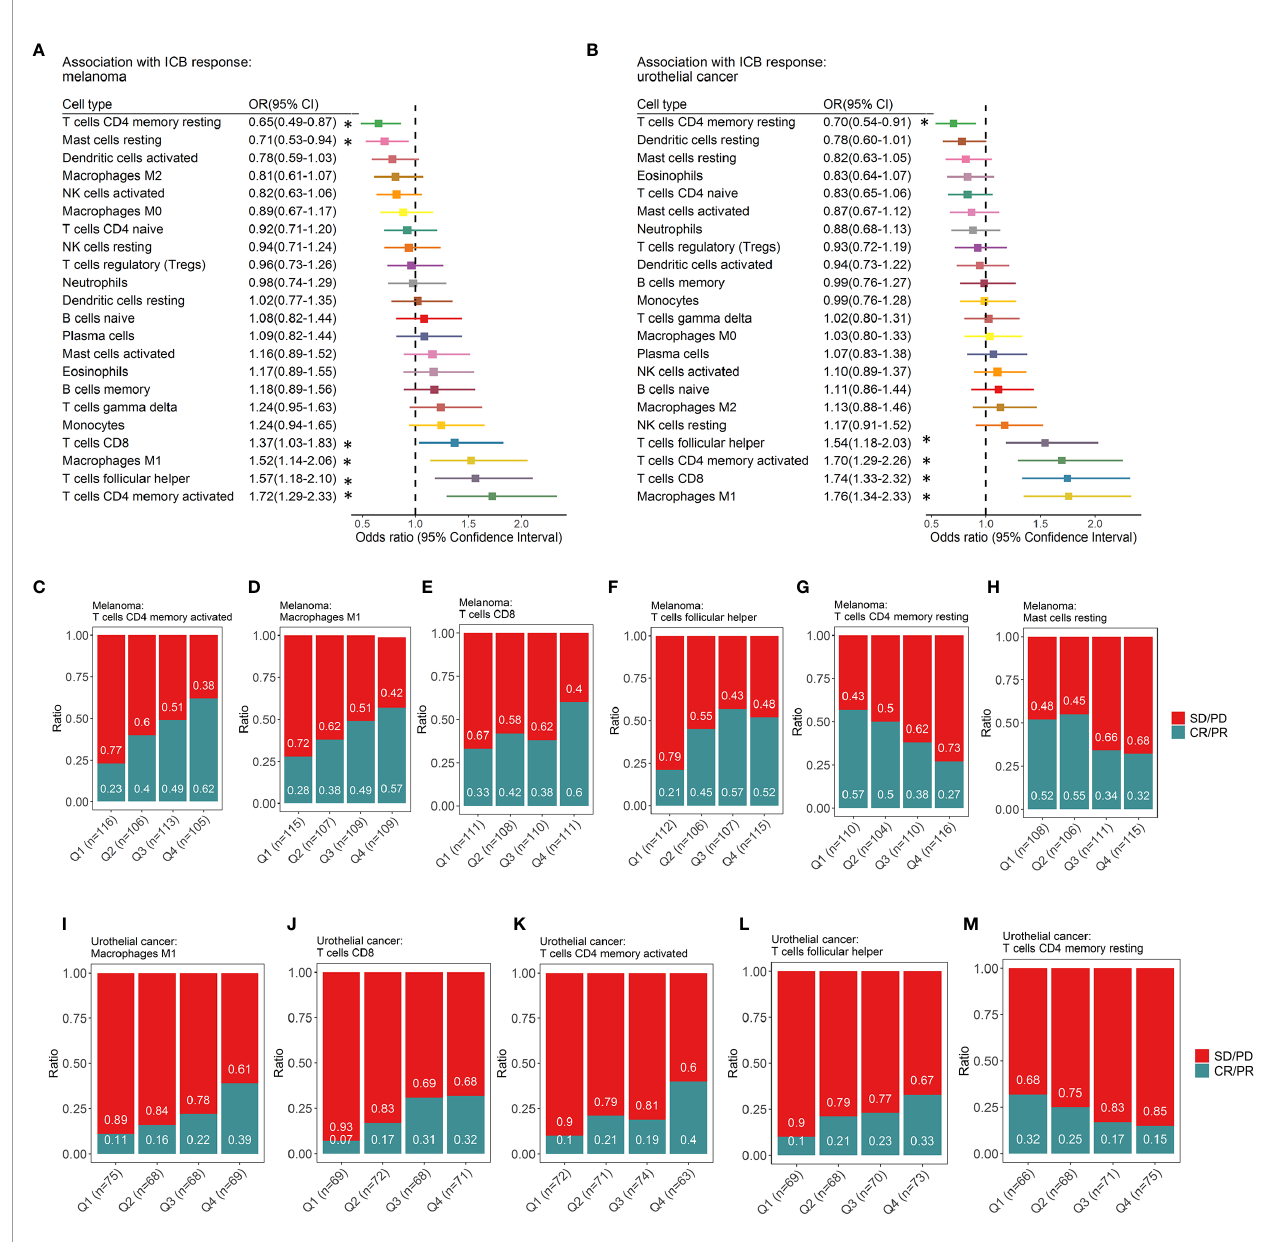
FIGURE 4 | Associations between ICI response and tumor-in fi ltrating immune cell subtypes. Forest plot demonstrating ORs (boxes) and 95% CIs (horizontal lines) for the association with response to ICI therapy in melanoma (A) and urothelial cancer (B) . The size of the box is negatively proportional to the standard error of the OR. * denote ORs with a p-value < 0.05. Spine plots demonstrating the distribution of response rates within quartiles of immune cell subsets (C-M) . OR, odds ratio; CI, con fi dence